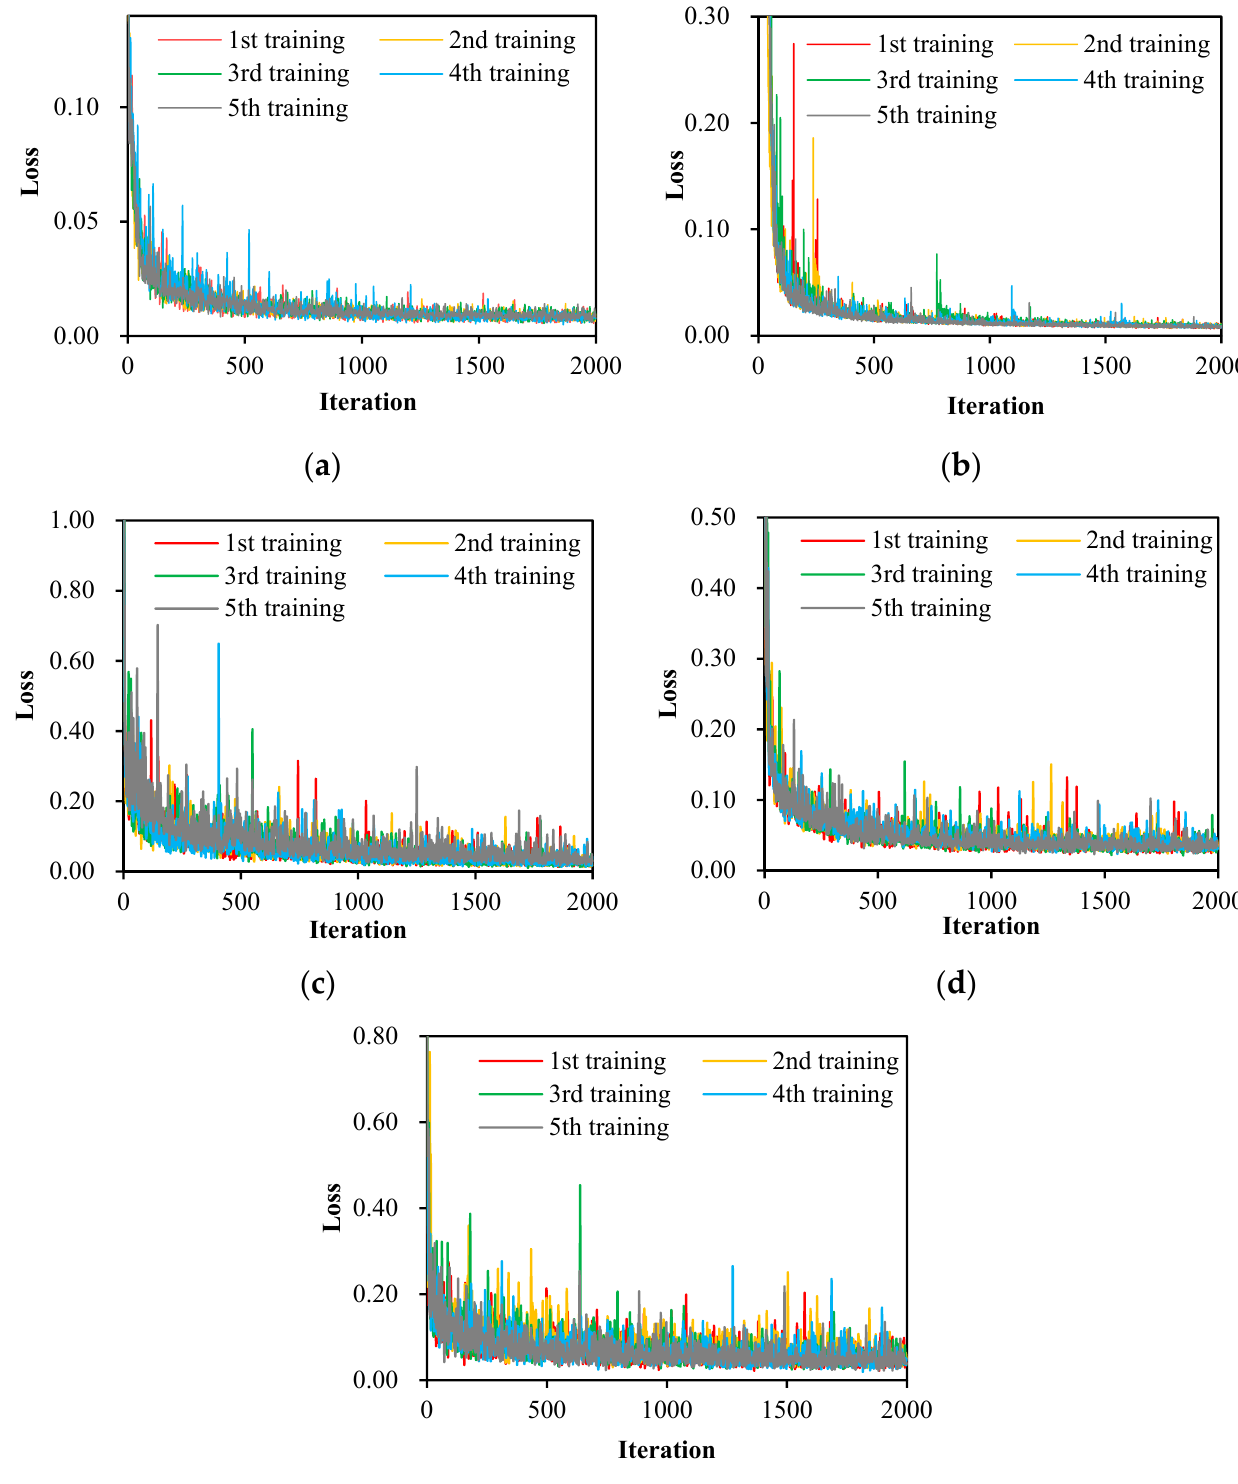
Figure 4. Training losses over iterations of five semantic segmentation networks: ( a ) FCN-8s, ( b ) Seg-